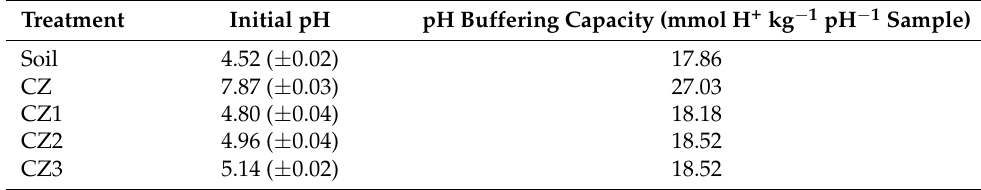
Figure 2. The linear between the added mmol H + kg − 1 sample and pH of suspension demonstrating R 2 > 0.73 at p = 0.01. Table 22. Effects of soil only, clinoptilolite zeolite only, and soil with different amounts of clinoptilolite zeolite on the initial suspension pH and pH buffering capacity.